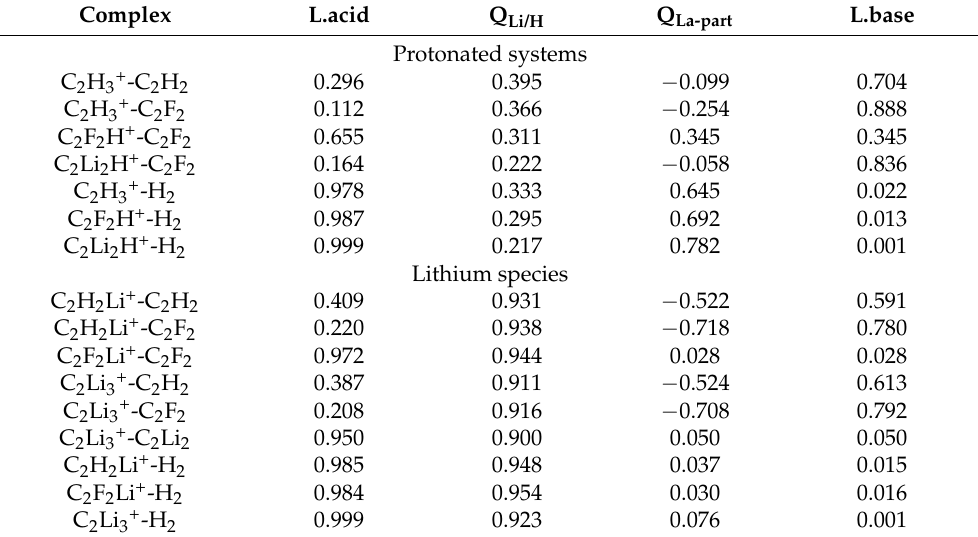
Table 5. The parameters related to QTAIM charges (in au). The total Lewis acid and Lewis base units’ charges are given (marked as L.acid and L.base, respectively). The charge of the H-atom or Li-atom located in the center of the complex, Q Li/H , the part of the Lewis acid unit (without the H or Li center), Q La-part . Complex L.acid Q Li/H Q La-part L.base Protonated systems C 2 H 3+ -C 2 H